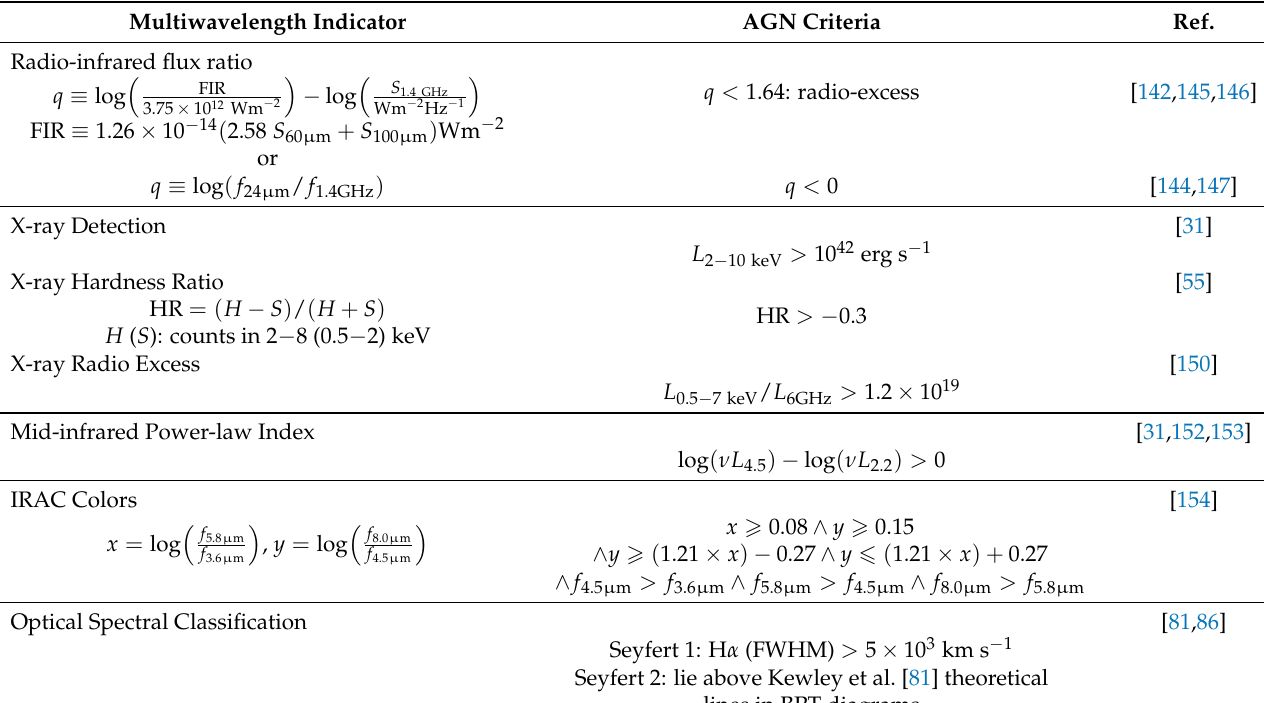
Table 1. A summary table for multiwavelength AGN diagnostics in (U)LIRGs. Multiwavelength Indicator AGN Criteria